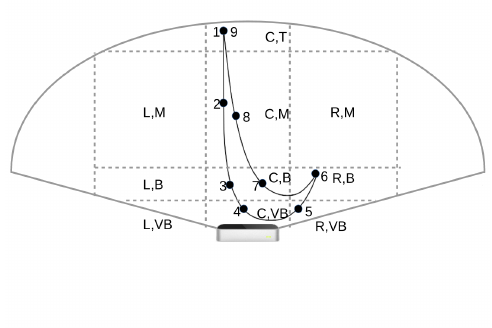
Fig. 6: Sequential positions of the user’s hand, tracked by the Leap Motion : (1-C, T), (2-C,M), (3-C, B), (4-C, VB), (5-R, VB), (6-R, B), (7-C, B), (8-C, M) e